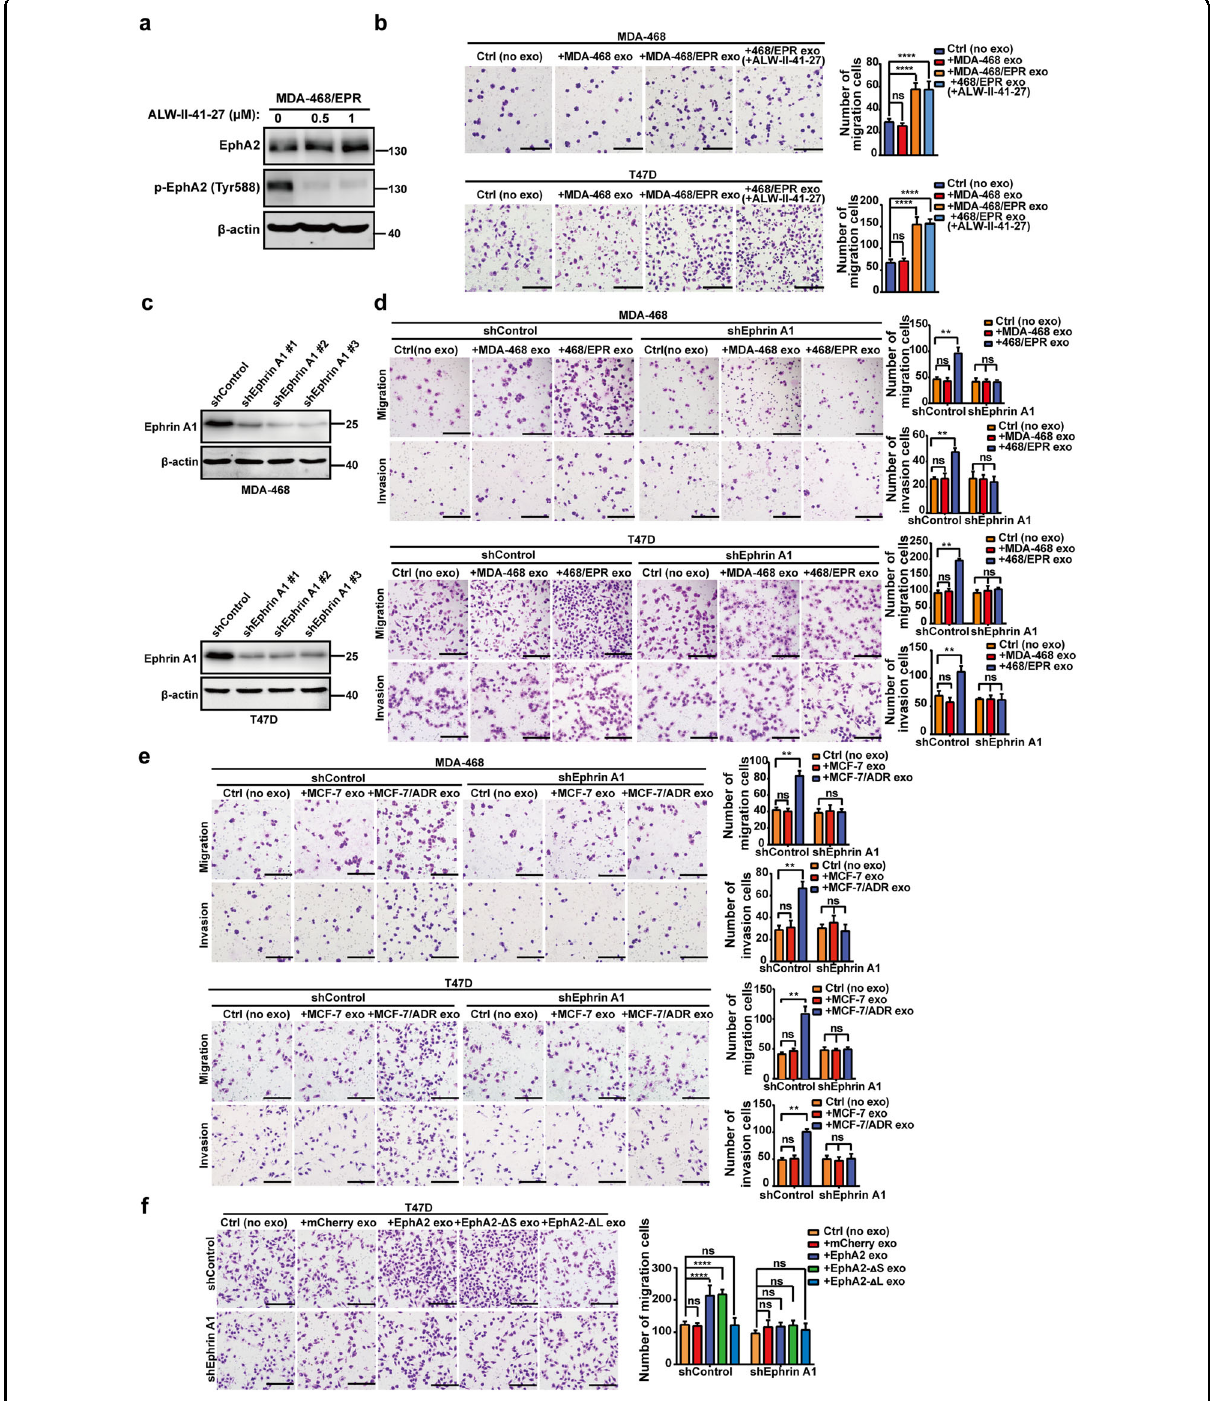
Fig. 5 Drug-resistant cell-derived exosomal EphA2 promoted the migration and invasion of breast cancer cells by inducing Ephrin A1 reverse signaling. a Treatment with ALW-II-41-27 suppressed the phosphorylation of EphA2 at the Tyr588 site in drug-resistant breast cancer cells. b Exosomes derived from ALW-II-41-27-treated drug-resistant cells (DR-Exos) exerted migratory promoting effects on sensitive breast cancer cells. The drug- resistant cells were treated with ALW-II-41-27 (500nM) for 12h, and then the exosomes were collected and used for further assay. All experiments were repeated at least three times. **** P <0.0001 and ns P >0.05 indicate no statistical signi fi cance. c Western blotting analysis of the expression of Ephrin A1 in MDA-MB-468 and T47D cells infected with lentivirus expressing control and Ephrin A1-speci fi c shRNAs. d , e Exosomes derived from drug-resistant cells failed to promote the migration and invasion abilities in Ephrin A1 knockdown cells. All experiments were repeated at least three times. ** P <0.01 and ns P >0.05 indicate no statistical signi fi cance. f Exosomes carrying EphA2 and EphA2- Δ S failed to promote the migration of Ephrin A1 knockdown cells. All experiments were repeated at least three times. **** P <0.0001 and ns P >0.05 indicate no statistical signi fi cance. Scale bars: 200 μ